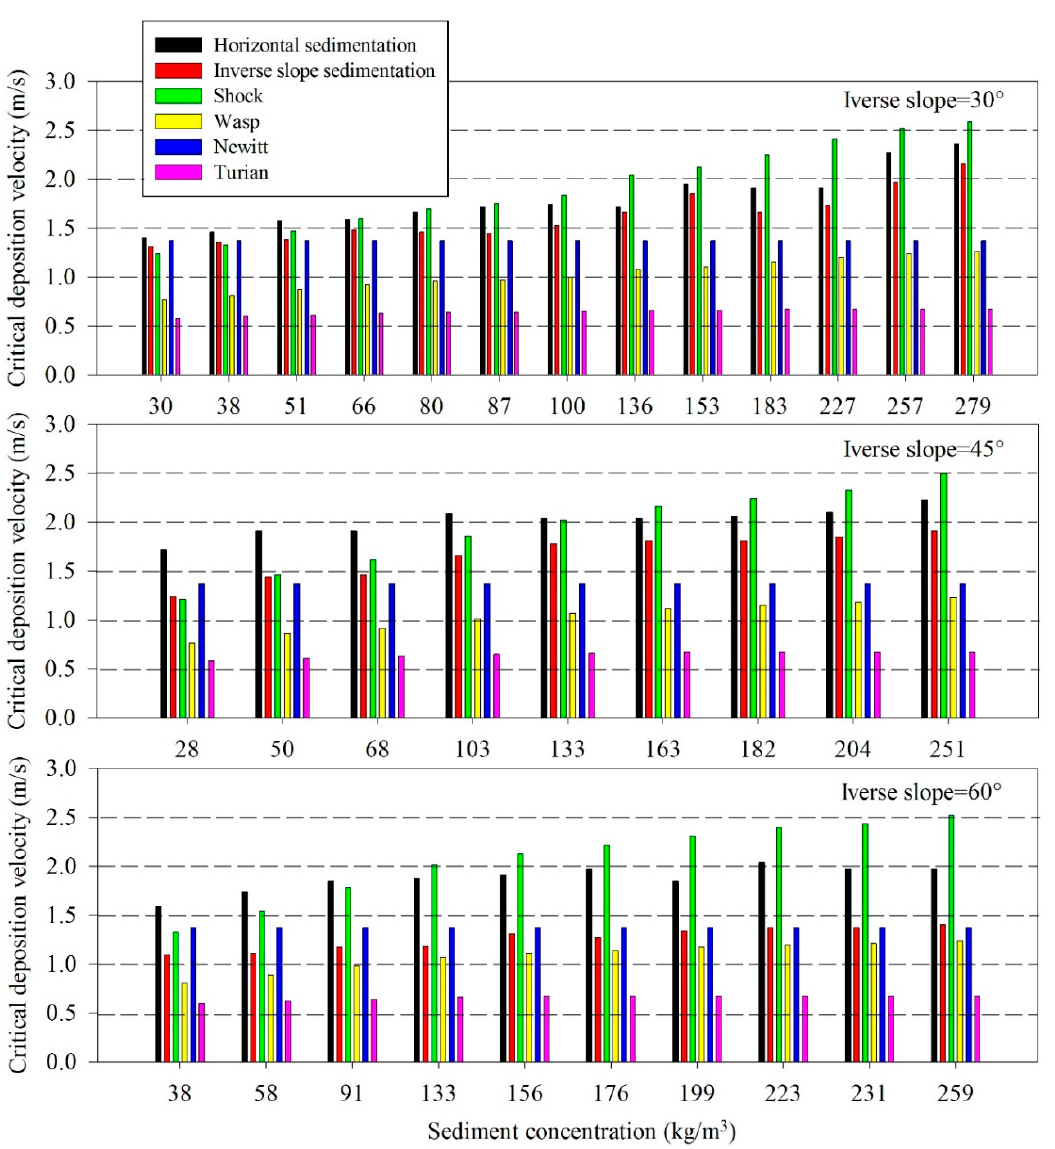
Figure 5. The measured value of critical deposition velocity compared with that predicted by different formulas.